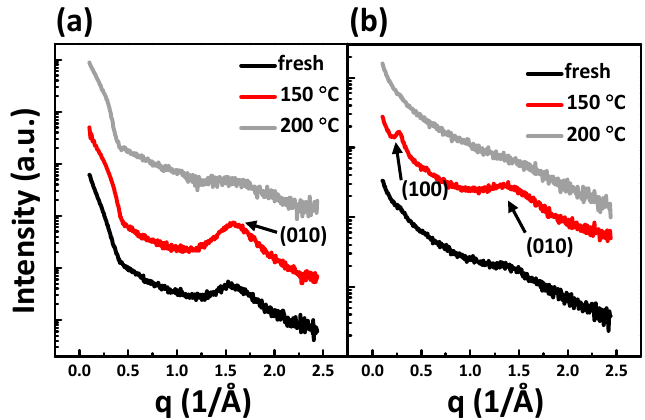
Figure 3. ( a ) Out-of-plane and ( b ) in-plane XRD patterns of the PQCTQx films.